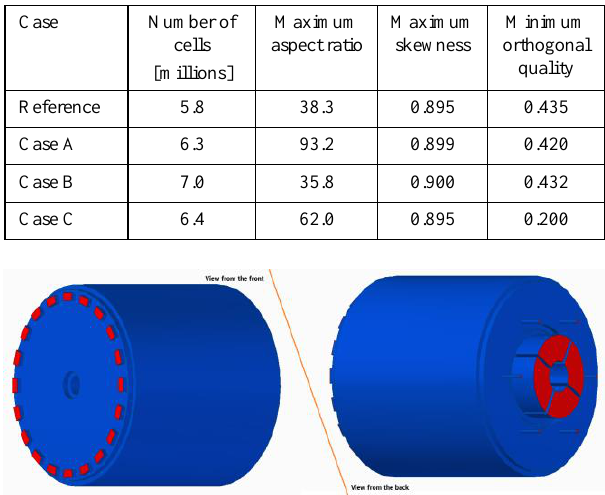
Table 2. Quality parameters of the meshes